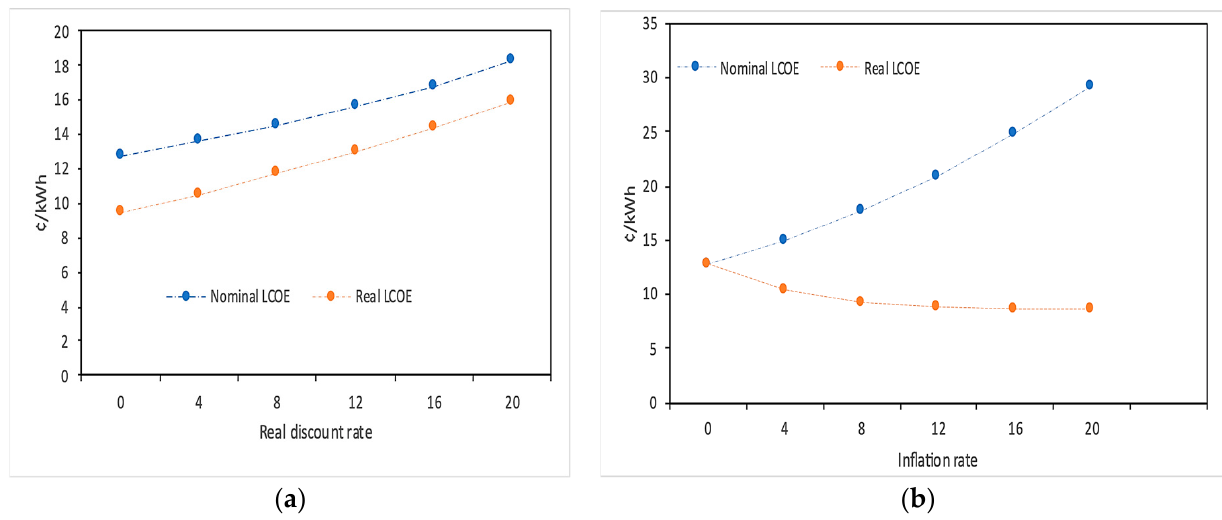
Figure 11 . Variations in LCOEs with ( a ) real discount and ( b ) inflation rate . Figure 11. Variations in LCOEs with ( a ) real discount and ( b ) inflation